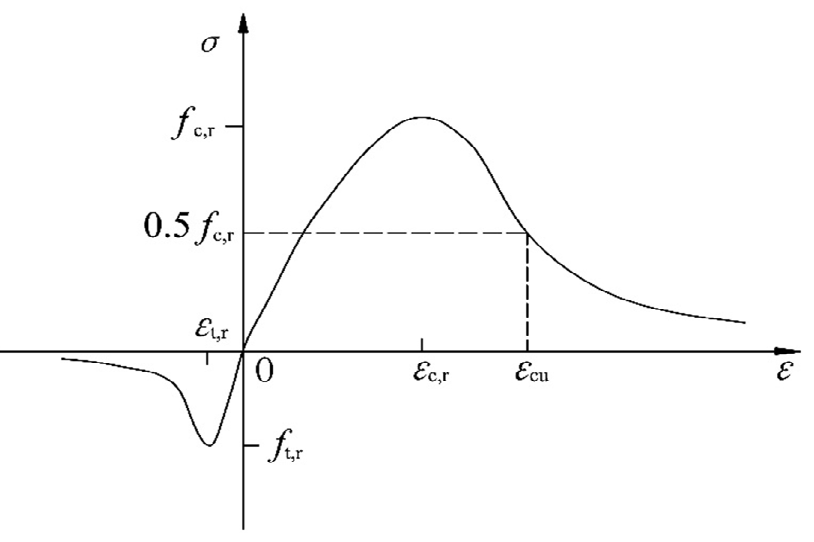
Figure 19. Uniaxial stress–strain curve for concrete.